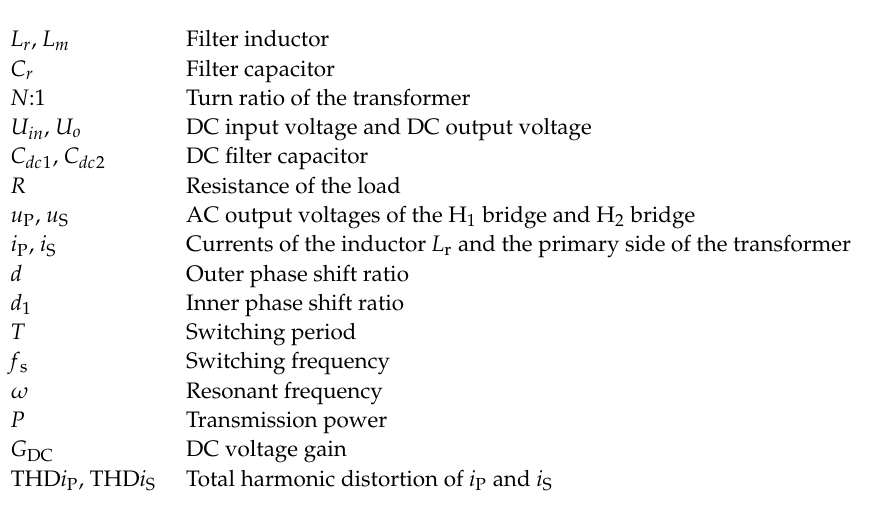
to 70 Ω . ( a ) SPS modulation; ( b ) Soft ‐ switching and no backflow power control. to 70 Ω . ( a ) SPS modulation; ( b ) Soft-switching and no backflow power